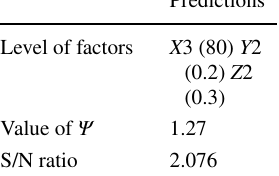
Table 8 Results of confirmatory experiments